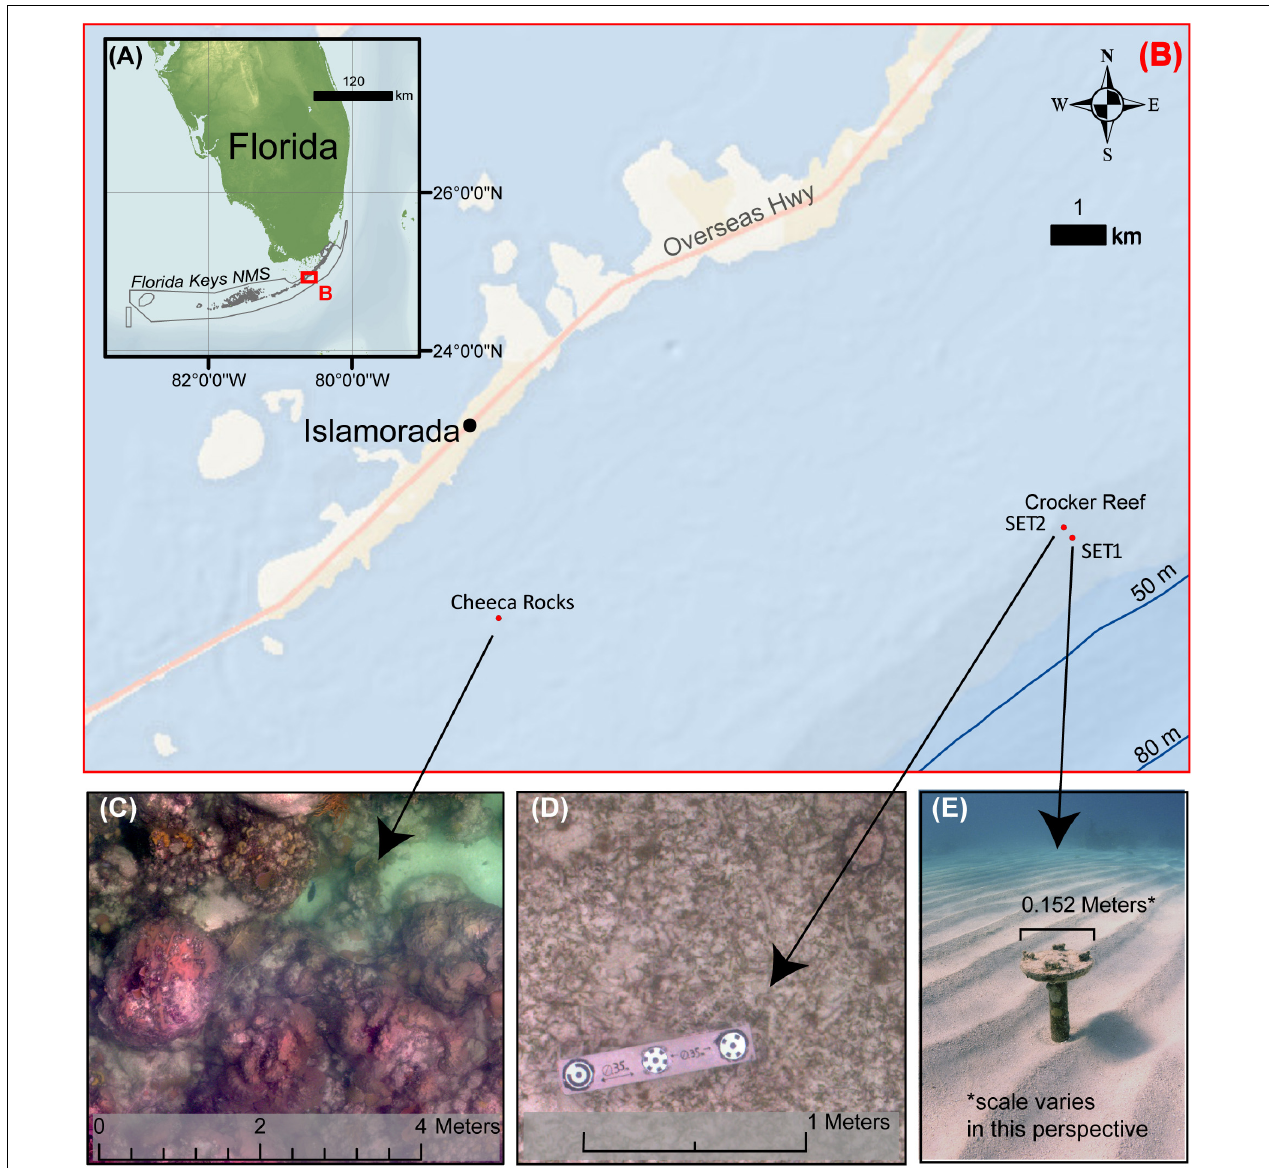
FIGURE 1 | (A) Geographic location of fieldwork in the U.S. Florida Keys, global bathymetry (GEBCO), with operation area outlined. (B) Larger scale map of field site showing the locations of Surface Elevation Table (SET) stations and the Cheeca Rocks reef site location. (C) Example of the Cheeca Rocks coral reef orthomosaic generated from imagery collected using SQUID-5 (depth ranges from ∼ 2.5 m to over 4.5 m). (D) Sample of orthomosaic generated above SET station 2 from SQUID-5 imagery with scalebar and circular encoded targets attached (water depth ∼ 3.6 m). (E) Perspective photo of SET station 1 with protective cover plate installed showing sandy seabed and ripples typical at the